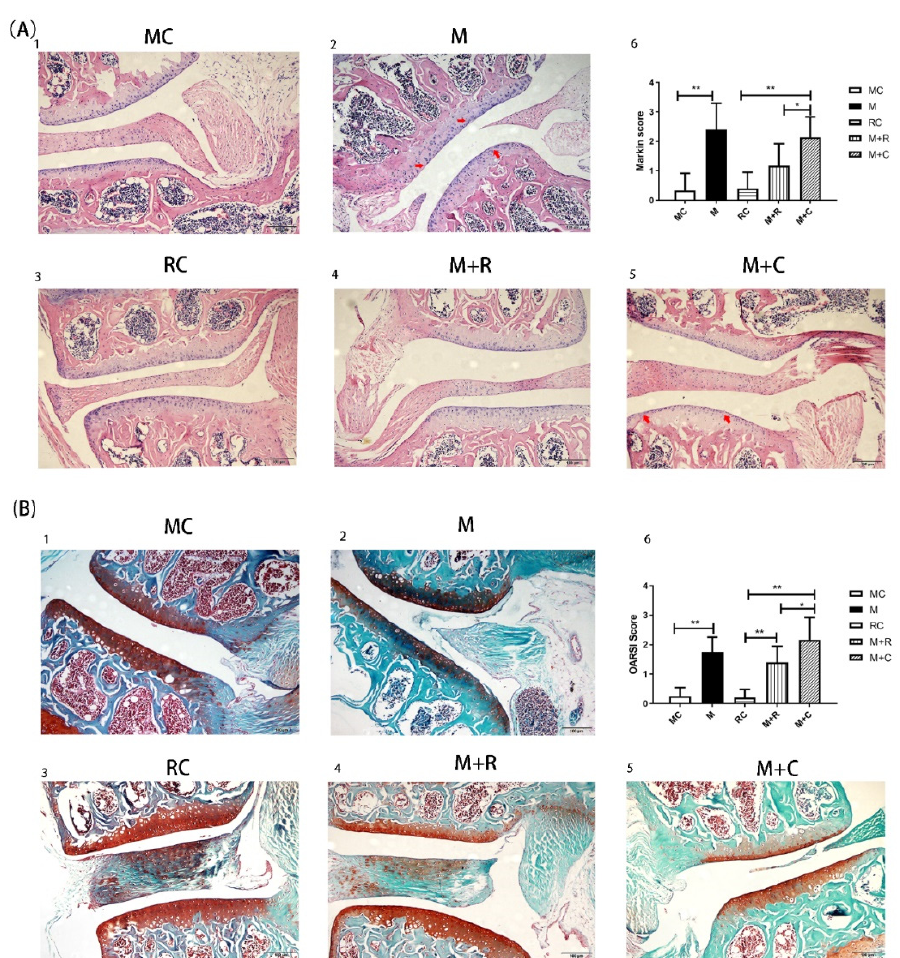
Figure 2. Histological evaluation of joint tissue sections by HE and safranin O staining. ( A ) HE stained histological images of the knee joints; A(1) : HE staining for MC group; A(2) : HE staining for M group; A(3) : HE staining for RC group; A(4) : HE staining for M + R group; A(5) : HE staining for M + C group; A(6) : The Mankin score of each group; ( B ) Safranin-O-Fast Green stained histological images of the knee joints of mice; B(1) : Safranin-O-Fast Green staining for MC group; B(2) : Safranin-O-Fast Green staining for M group; B(3) : Safranin-O-Fast Green staining for RC group; B(4) : Safranin-O-Fast Green staining for M + R group; B(5) : Safranin-O-Fast Green staining for M + C group; B(6) : The Mankin score of each group. The red arrow indicates the site of cartilage damage. (n = 8, * p < 0.05, ** p < 0.01.).